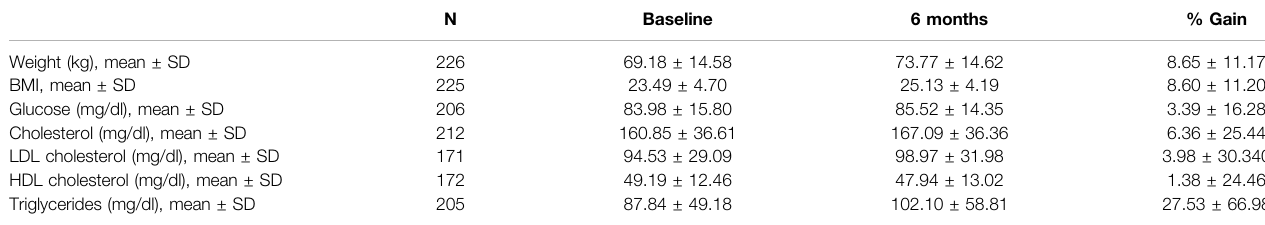
TABLE 1 | Metabolic data of the study participants at baseline and at the 6-months follow-up. N Baseline 6 months %